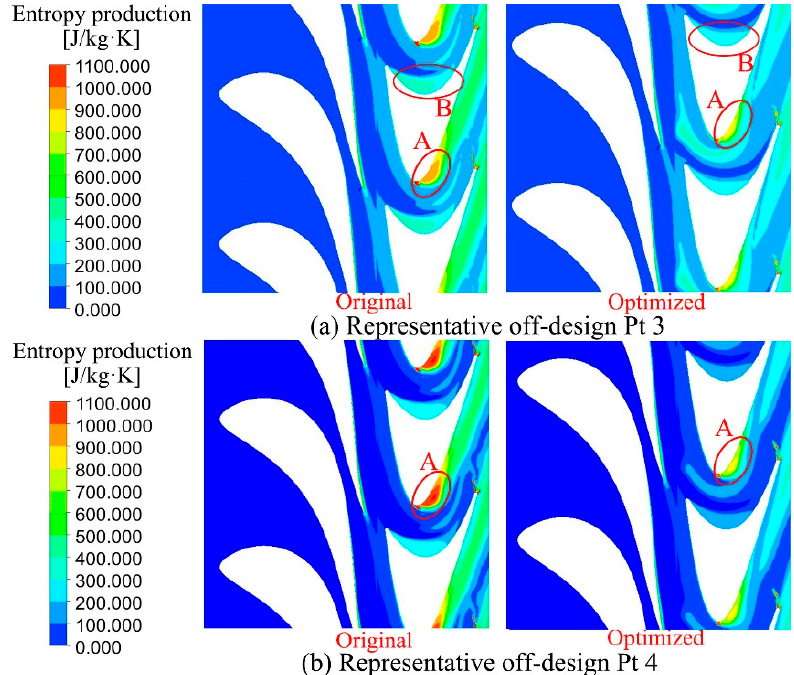
Figure 15. Entropy production of original and optimized turbine at 50% span.